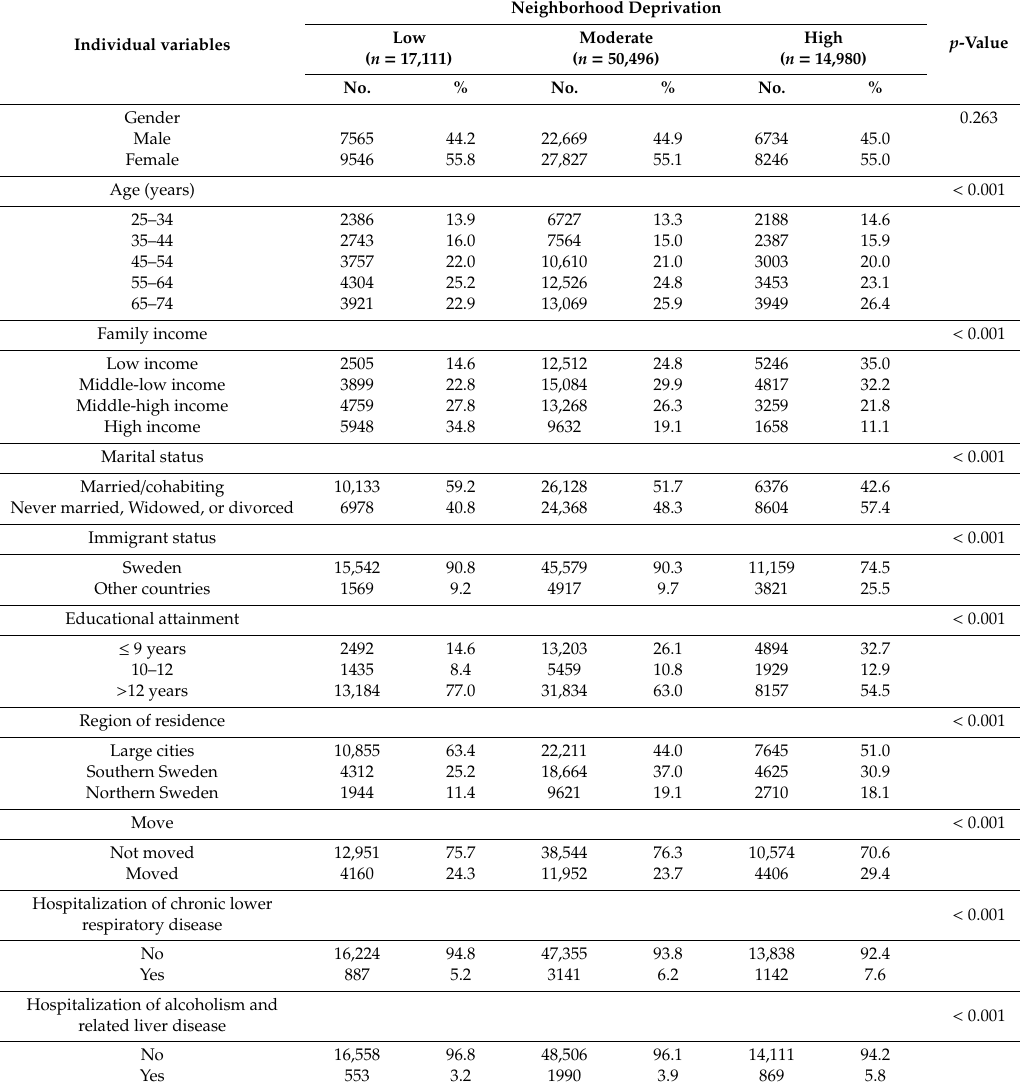
Table 2. Baseline characteristics of events of autoimmune disorders in neighborhoods.